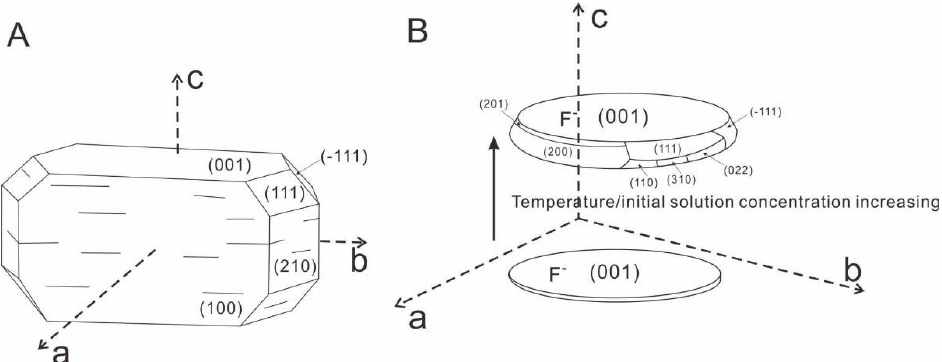
Figure 8. A schematic diagram of zirconia crystals with high (001) facets, demonstrating ( A ) the crystallographic structure of an ideal monoclinic zirconia (e.g., baddeleyite) and ( B ) a growth model for zirconia micro-nanoflakes.